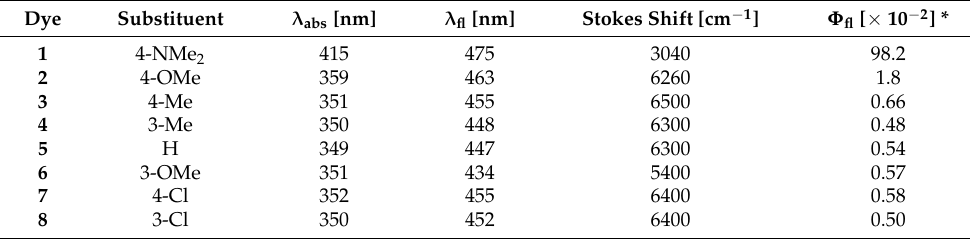
Figure 2. UV-Vis spectra of 2-phenacylbenzoxazole difluoroboranes in acetonitrile as a solvent recorded at room temperature: ( A ): absorption, ( B ): fluorescence at excitation wavelength 355 nm. The corresponding spectroscopic data are listed in Table 1. Table 1. Spectroscopic properties of photosensitizers in acetonitrile as